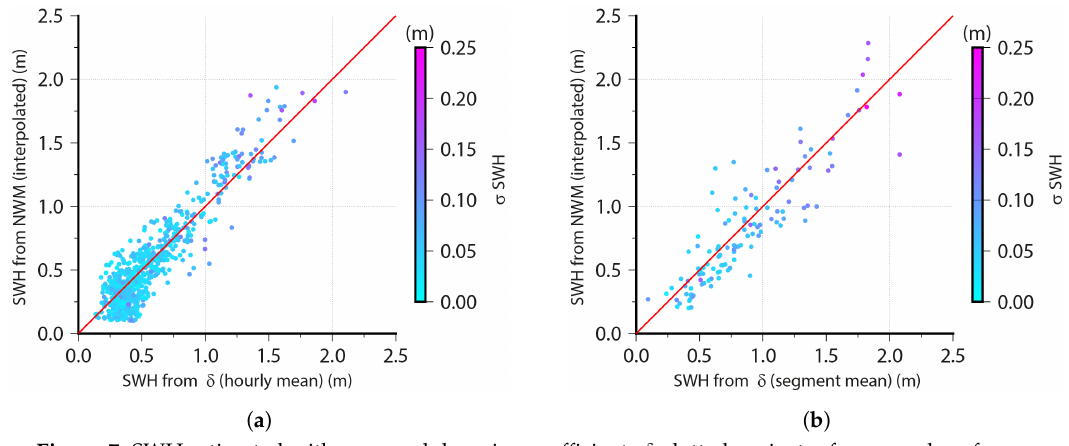
Figure 7. SWH estimated with averaged damping coefficients δ plotted against reference values from a numerical wave model. Point shading with respect to the σ of the estimated SWH. Function course for a perfect positive correlation (red). ( a ) Data from the static antenna. ( b ) Data from the ship-based